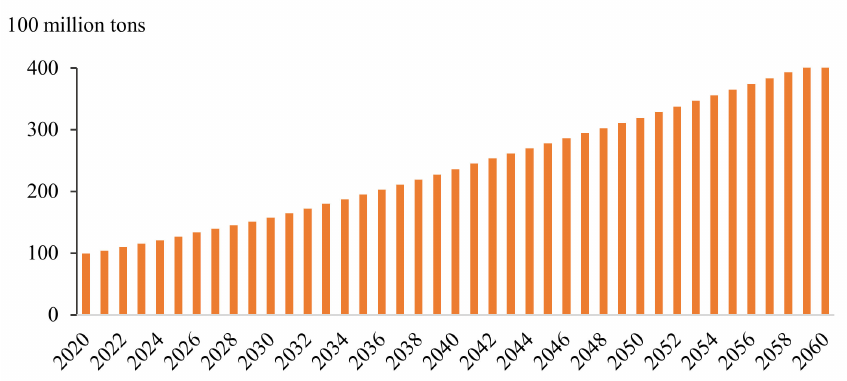
Figure 4. GDP and its annual growth rate in the baseline scenario (BAU) from 2020 to 2060.